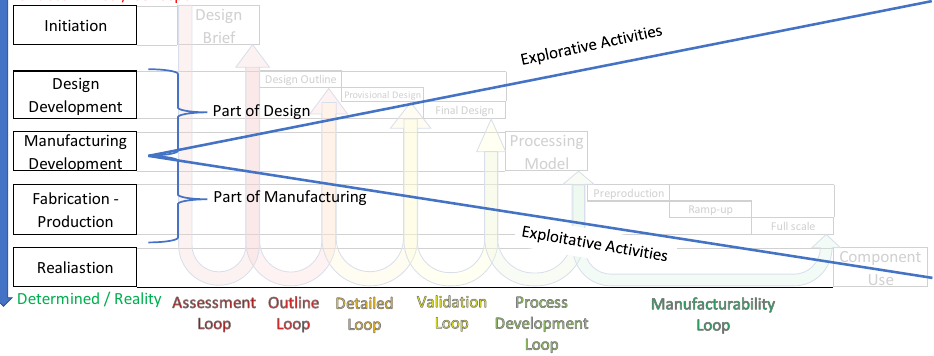
Figure 5. Composite-manufacturing development, adapted from [2].